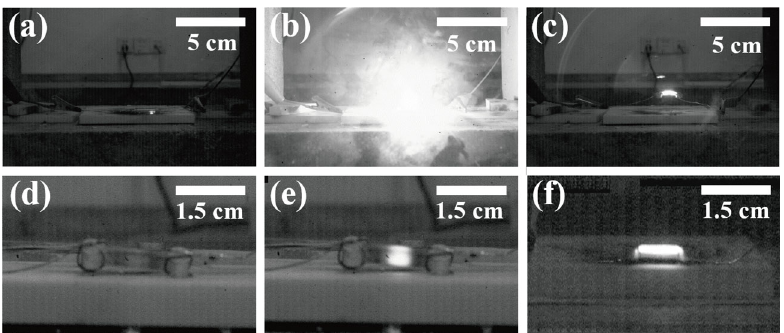
Fig. 2 Snapshots of the FS-A1 and FS-B1 samples during the FS process: (a) 1 s before FS, (b) when FS initiated, (c) at the stable stage, (d) 1 s, (e) 5 s; and (f) 20 s after applying the electric field.